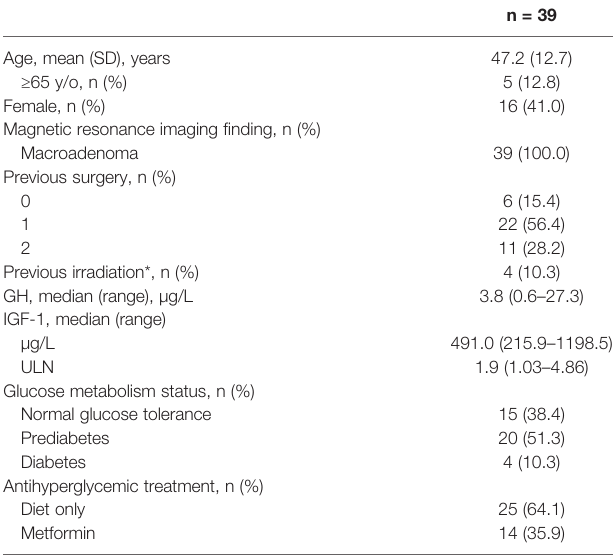
TABLE 1 | Baseline characteristics of the cohort.